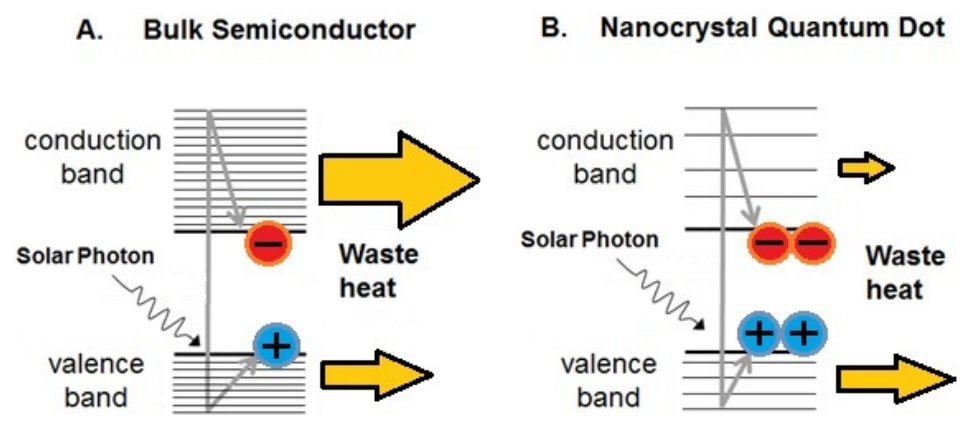
Figure 1. Photogeneration of charges in a ( A ) bulk semiconductor and ( B ) a nanocrystal quantum dot. In ( B ) quantum confinement effects increase the separation between energy levels, inhibiting phonon cooling, enhancing the multiple exciton generation (MEG) process and reducing waste